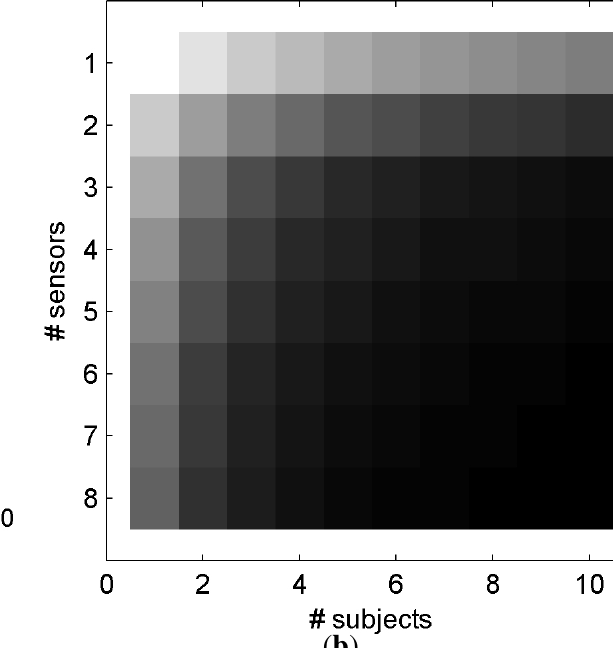
Figure 8. AUC based on the number of electrodes and subjects with the SS for electrode selection and O for fusing the classifier outputs across subjects. ( a ) 3D sum representation of the AUC; ( b ) 2D representation of the AUC. (In Figure 8b, a dark gray level represents a high